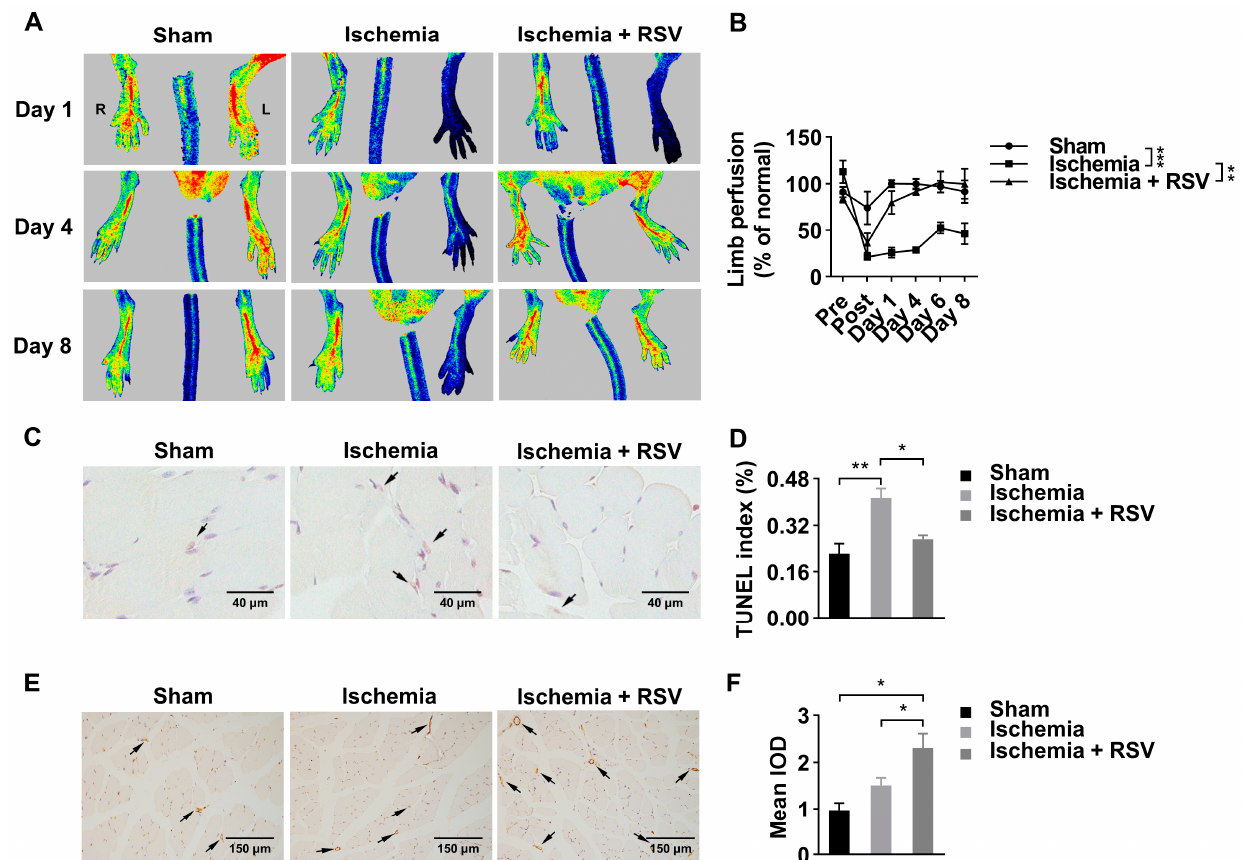
Figure 1. RSV promoted blood flow recovery and neovascularization in ischemic hind limbs of mice. ( A ) Laser Doppler measurement of hind limb blood flow was assessed 1 day before ischemic surgery as well as 0, 1, 4, 6, and 8 days after surgery. Red, green and blue represent high, medium and low blood perfusion degree, respectively. ( B ) Quantitative analysis of the blood flow perfusion ratio of ischemic-to-non-ischemic hind limbs. Data were shown as mean ± SEM ( n = 3–4, ** p < 0.01; *** p < 0.001). Gastrocnemius tissues were collected and processed for TUNEL staining ( C ) (400×, scale bar = 40 μ m) and CD31 staining ( E ) (200×, scale bar = 150 μ m). Quantitative analysis of the three groups ( D , F ) were evaluated. Data were shown as mean ± SEM ( n = 3, * p < 0.05; ** p < 0.01). Ischemia: mice performed with femoral artery severance surgery; Ischemia + RSV: hind limb ischemia mice administrated with resveratrol; Sham: mice performed with temporal femoral artery ligation for 5 min. IOD: integral optical density.